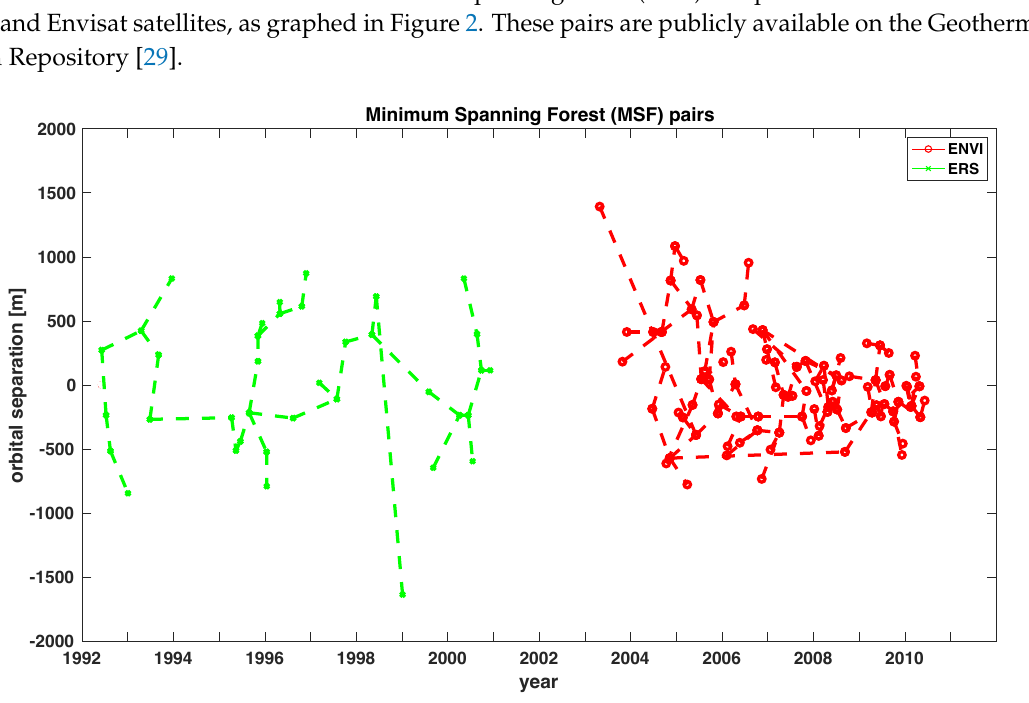
Figure 2. The graph showing pairs in the minimum spanning forest data set chosen by maximizing an empirical measure of quality γ ( i , j ) . ERS-1/2 pairs are shown in green (track 27) and ENVI pairs are shown in red (tracks 27 and 120). Pairs are shown according to their orbital separation in